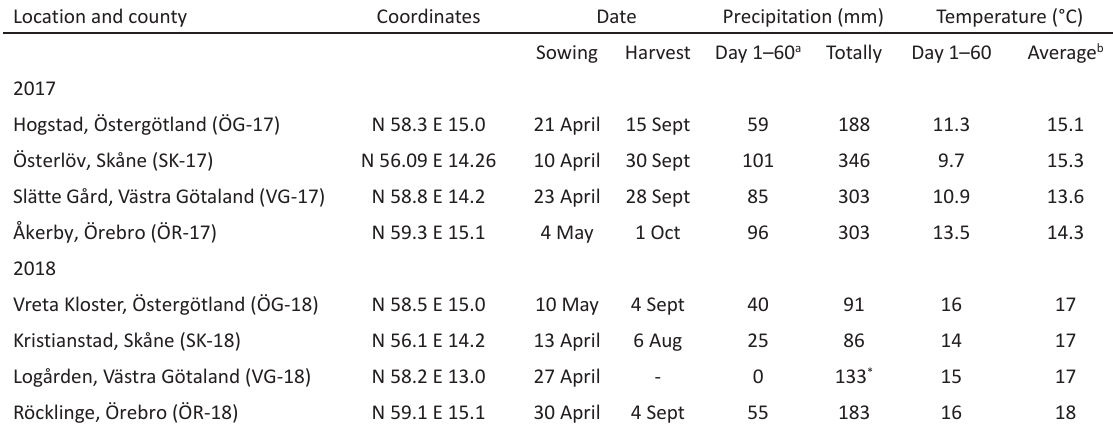
Table 1. Location of the field experiments, date for sowing and harvest, precipitation and temperature at sowing and harvest Location and